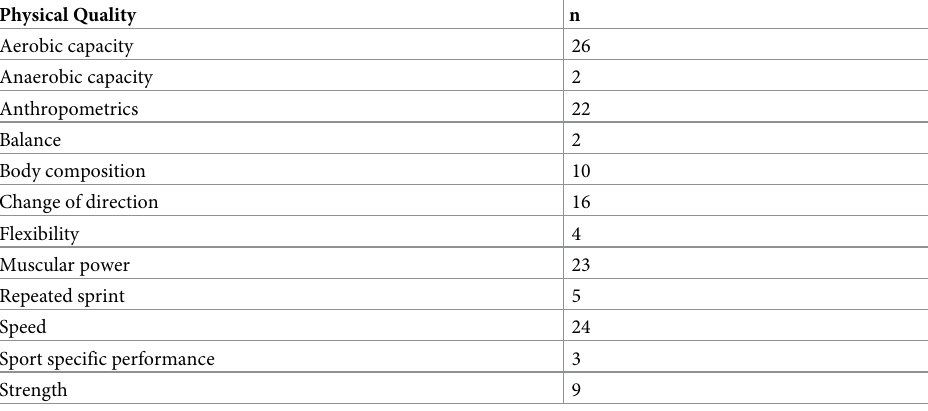
Table 3. The dependent variables assessed in the articles.